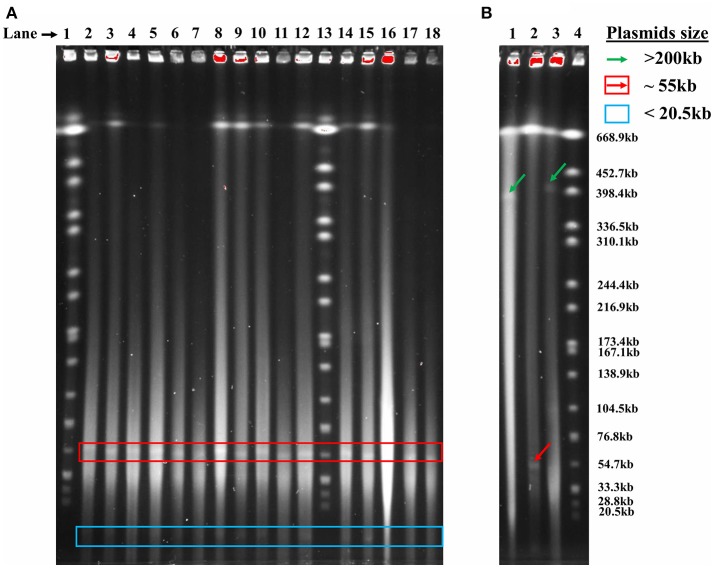
Detection of plasmids in actinomycete isolates using PFGE. (A) Lanes (left to right): (1) S. Branderup, (2) SY-20-2-5%, (3) SY-20-3-5%, (4) SY-20-5-10%, (5) SY-20-6-10%, (6) SY-20-7-5%, (7) SY-20-8-0%, (8) SY-20-9-0%, (9) SY-21-1-0%, (10) SY-21-2-0%, (11) SY-22-1-5%, (12) SY-22-2-5%, (13) Salmonella Branderup, (14) SY-24-1-0%, (15) SY-25-1-0%, (16) SY-25-5-0%, (17) SY-25-9-0%, (18) SY-25-4-10%. (B) Lanes (left to right): (1) SW-19-2-1-0%, (2) SW-20-2-10%, (3) SW-23-2-10%, (4) S. Branderup.